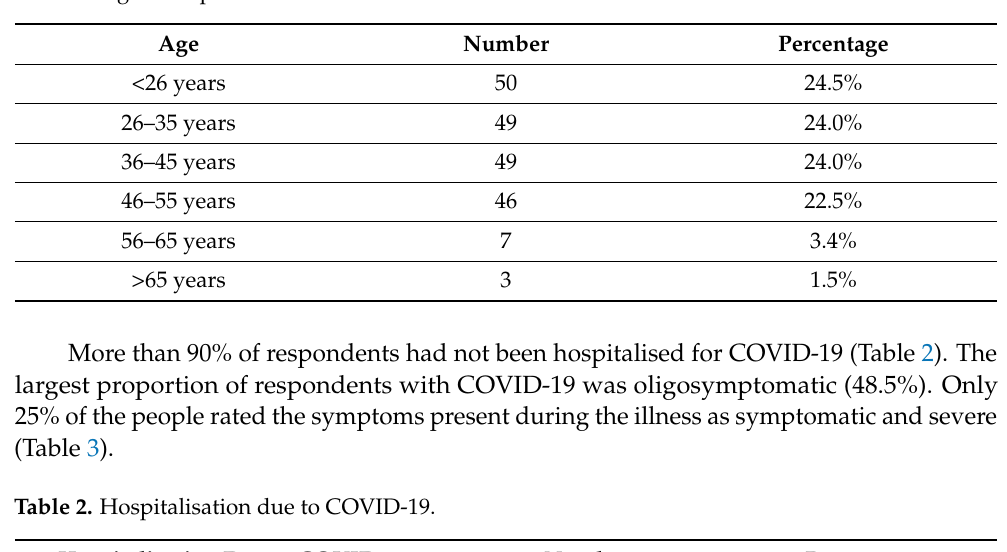
Table 1. Age of respondents.